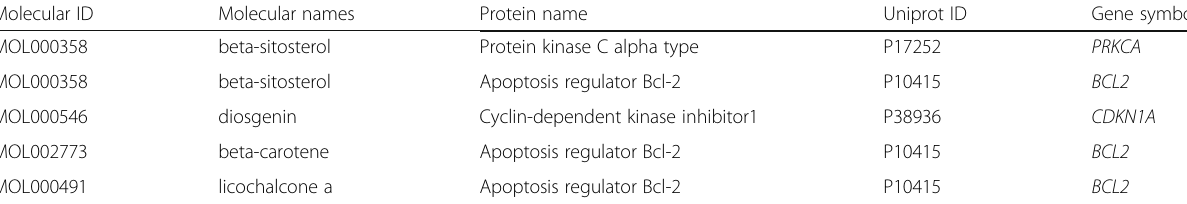
Table 4 The genes involved in two pathways for molecular docking